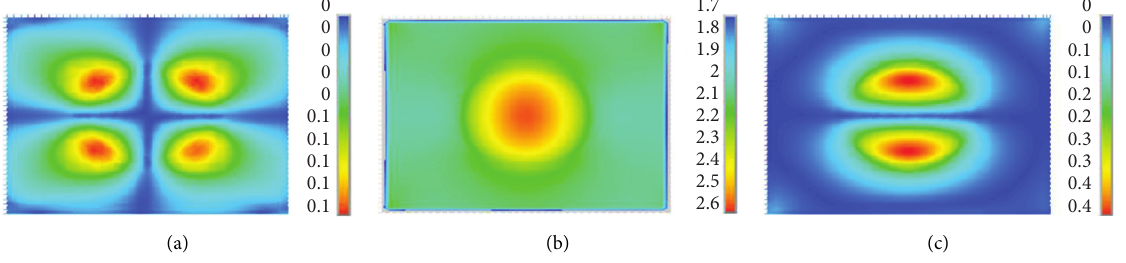
� 500m/s). Top view displacement cloud s